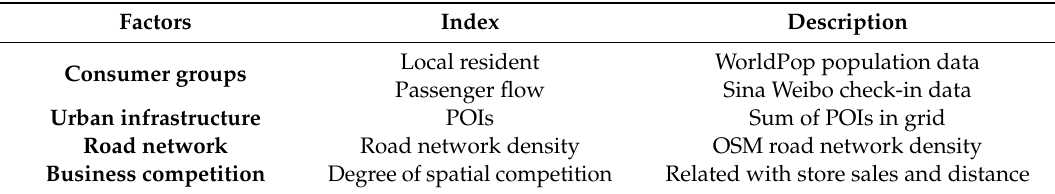
Table 2. Features considered in this